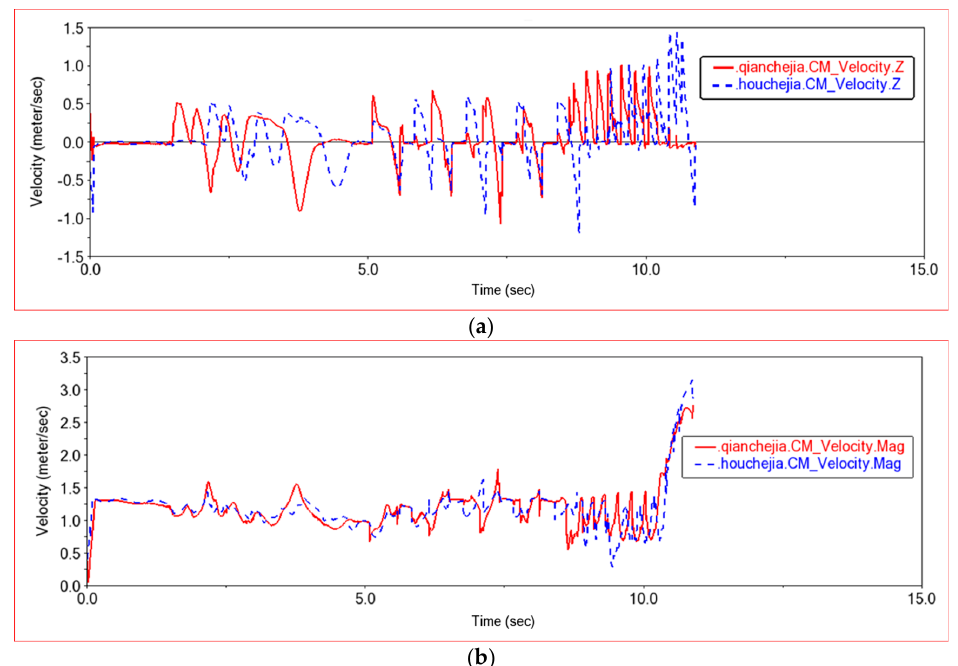
Figure 14. Speed comparison between front frame and rear frame. ( a ) The z-axis speed curve of the front frame and the rear frame, ( b ) The speed curve of the front frame and the rear frame. qianchejia.CM-Front frame center of mass; houchejia.CM-Rear frame center of mass. Figure 15 shows the angular velocity curve of the front frame joint link and the rear frame joint link in this experiment. On a flat road section, because the four wheels are driven at the same speed and move forward at a constant speed, the joint links of the front velocity of the joint links is basically unchanged and remains at 0. When an obstacle is encountered, the body posture changes. In order to adapt to the terrain, the connecting rod rotates at an appropriate angle to change the body posture, and the angular velocity of the front and rear joint links changes. From Figure 15, it can be seen that the angular velocity curves of the joint links on the left and right sides of the front frame completely overlap, and the angular velocity curves of the joints on the left and right sides of the rear frame also completely overlap. It can keep synchronized changes and keep the body in a stable state. When encountering an obstacle, the angular velocity of the joint link of the rear frame is greater than the angular velocity of the joint link of the front frame. Because when encountering obstacles, the rear body will provide thrust for the front body, push- ing the front body over the obstacle, the rear frame joint link will rotate more in the process of providing thrust to find the best thrust angle. Therefore, the angular velocity of the rear joint link is greater than that of the front joint link. From the above comparison chart, it can be seen that when the car climbs steps, the angular velocity changes more intensively. In order to adapt to the changes of each step of the steps and the bumps of the body when going up the steps, the joint link will rotate the angle and change the body posture, so the angular velocity changes frequently.